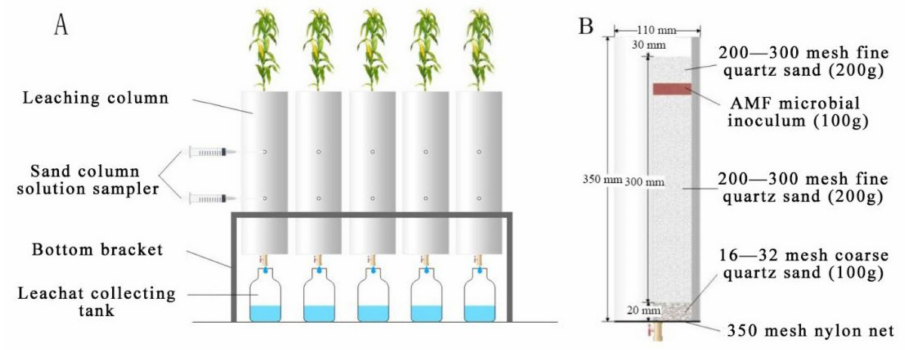
Figure 1. Filling and leaching of a sand column schematic diagram: ( A ) Schematic of the leaching device; ( B ) Schematic diagram of leaching